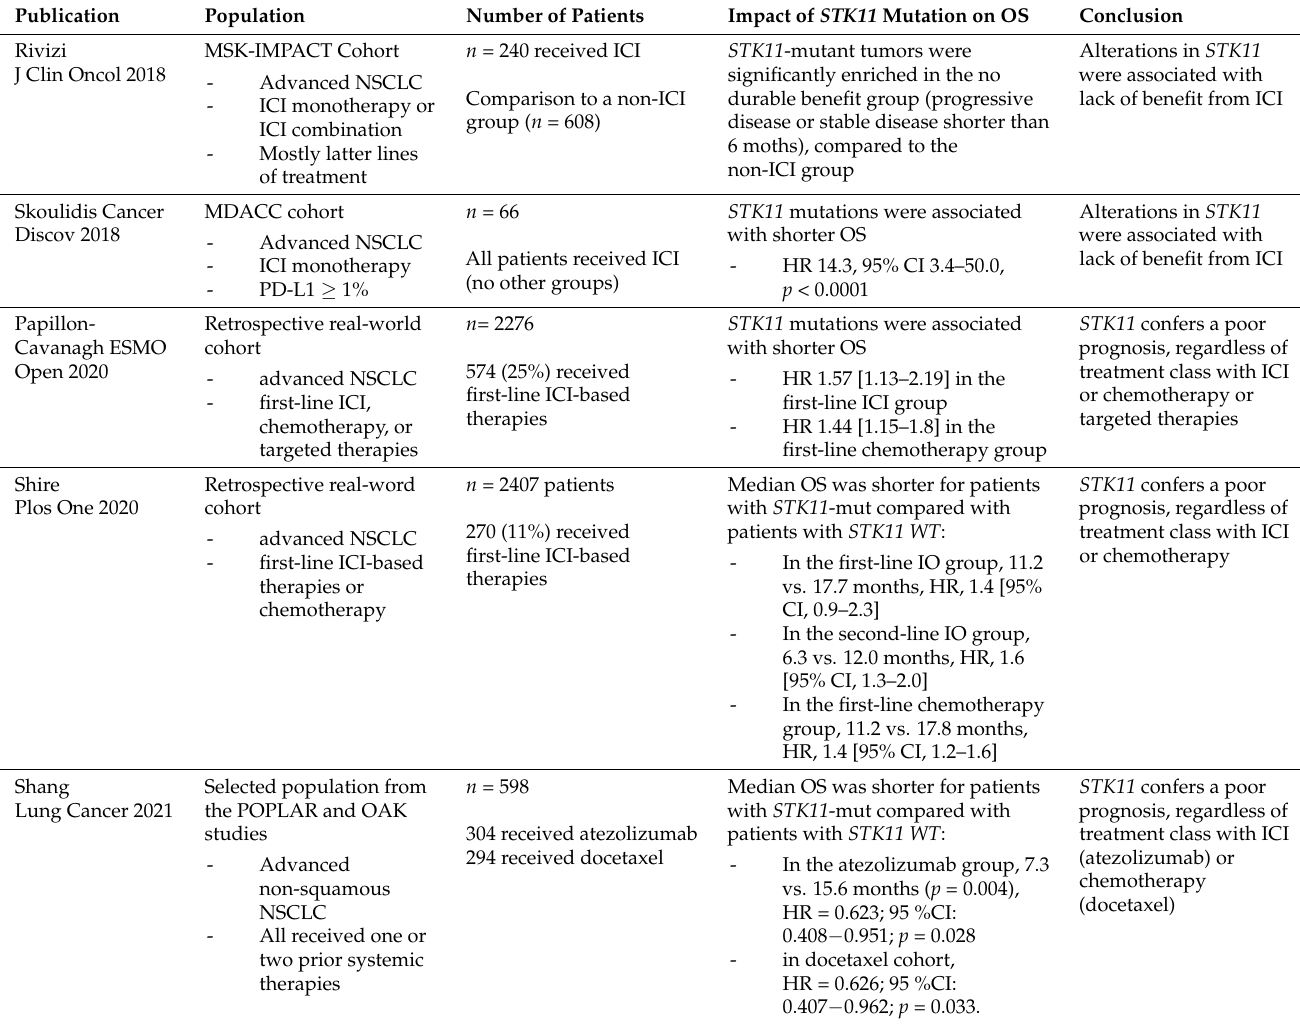
Table 2. Major retrospective studies evaluating prognostic or predictive impact of STK11 status on ICI